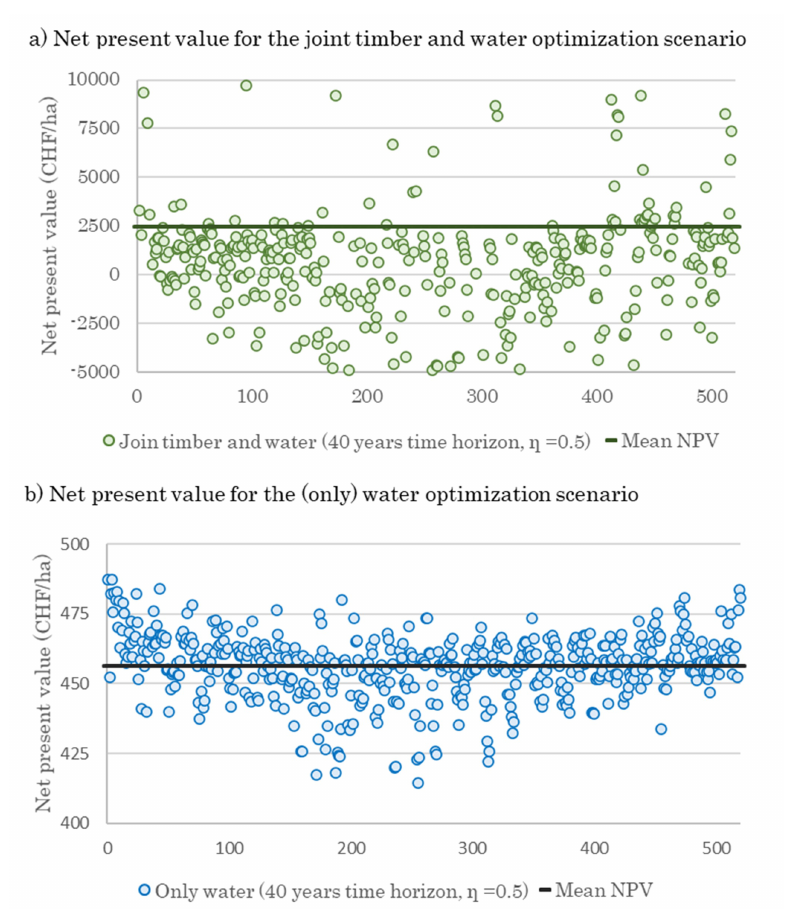
Figure 4. Net present value of water and joint timber and water benefits over a 40-year time horizon by cell grid (Results for the joint ( a ) timber and water and ( b ) only water maximization scenarios, a discount rate of 4% and a maximum harvesting rate ( η ) of